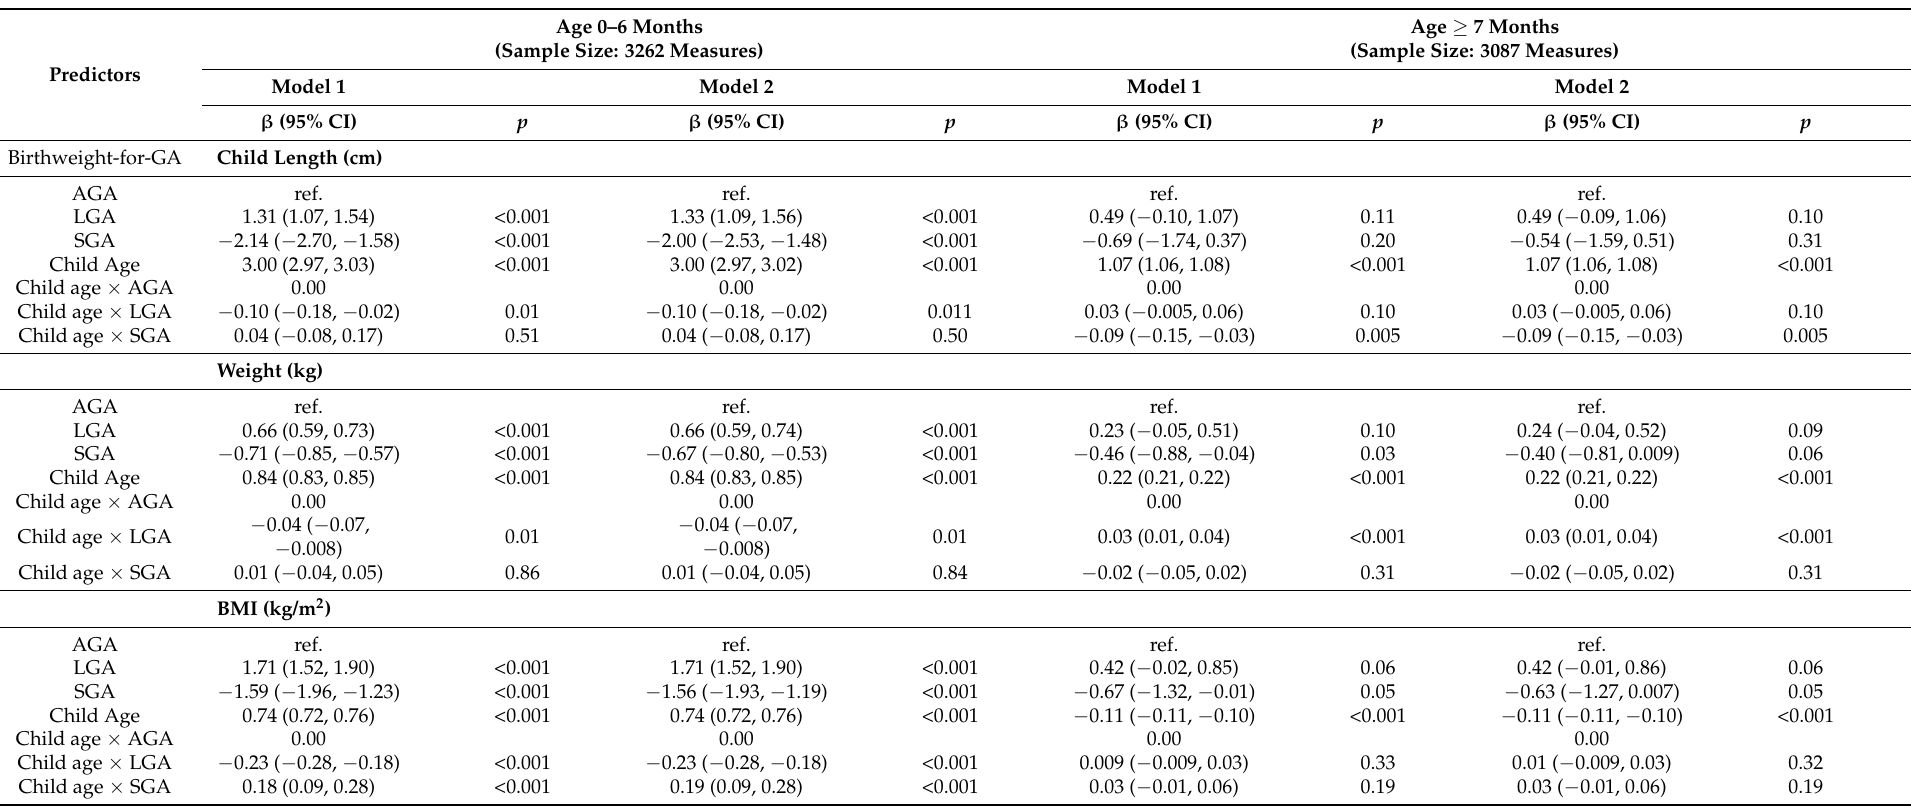
Table 2. Longitudinal data analysis of birthweight for gestational age status and growth trajectories for length, weight, BMI, and weight for length z-score by age from birth to 6 months and from 7 to ~25 months in 806